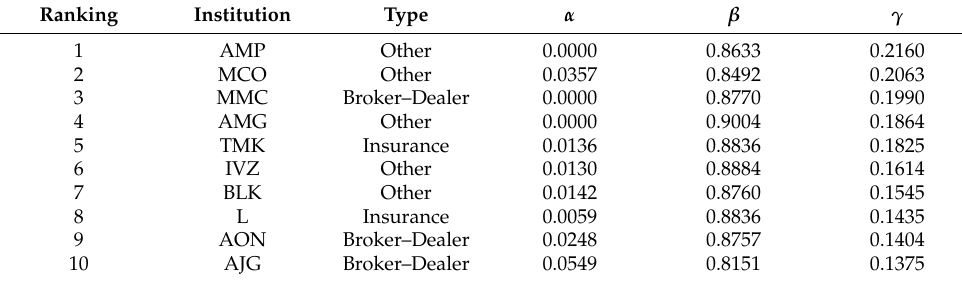
Table 3. Top ten in asymmetric effect ranking among sixty financial